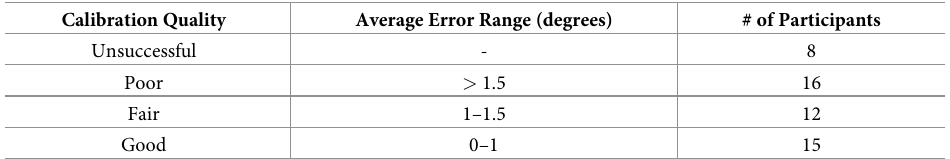
Table 2. Qualitative output results from calibration and validation procedures.